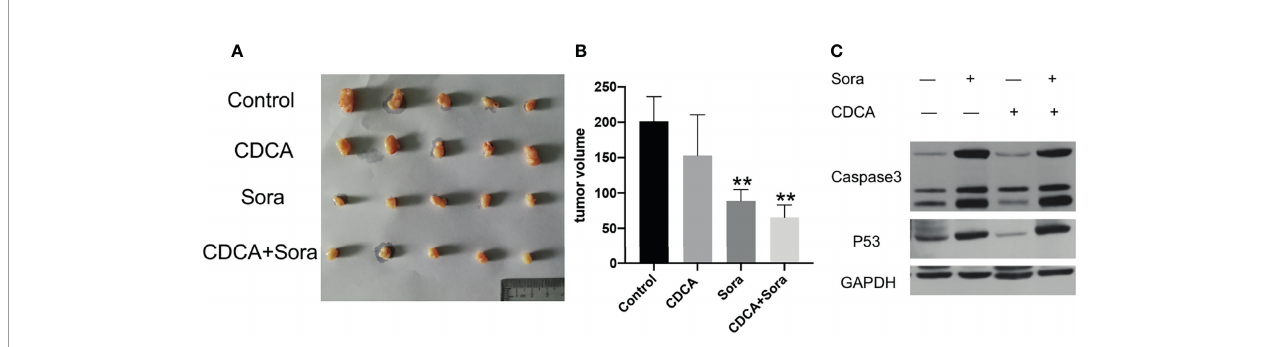
FIGURE 2 | CDCA plus sorafenib inhibits tumor growth and promotes tumor cell apoptosis in vivo . Four-week-old female Balb/c nude mice were injected subcutaneously in the right abdominal wall with 1 × 10 7 HepG2 cells in 200 m L sterile phosphate buffer. At a tumor volume of approximately 80 mm 3 the mice were divided into four groups (n = 5 per group) and treated by daily gavage. The control group was given 200 m L of saline, the CDCA group was given 30 m g CDCA/200 m L (15mg/kg), the sorafenib group was given 40 m g sorafenib/200 m L (20mg/kg), and the combination group was given CDCA 30 m g + sorafenib 40 m g/200 m L for 14 consecutive days. (A) Photographs of tumors after transplantation of HepG2 cells into nude mice followed by drug gavage for 14 days. (B) Tumor size in all the treatment groups. ** P < 0.01 vs. control group. (C) Western blot detection of apoptotic protein caspase 3 and p53 expression in